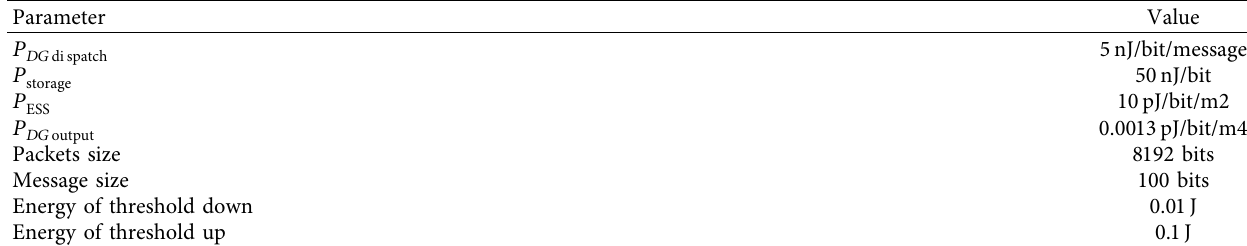
Table 4: Parameters used in simulation.